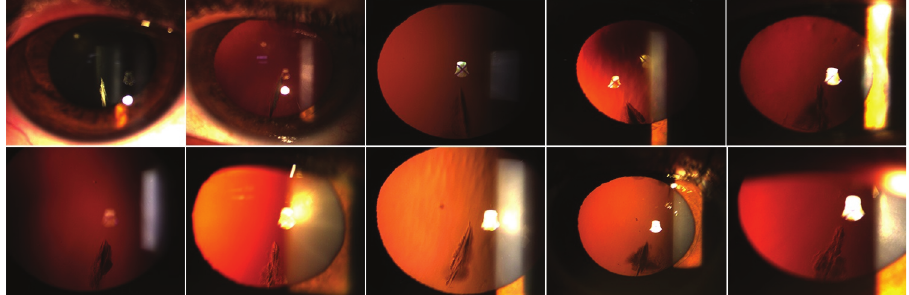
Figure 1. The typical inferior feather-shape lens opacity in 10 eyes of 10 cases from the cohort.